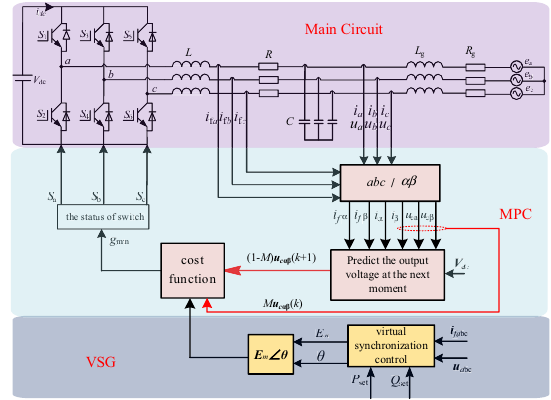
Fig. 5 VSG control block diagram based on the proposed weighted predictive voltage control